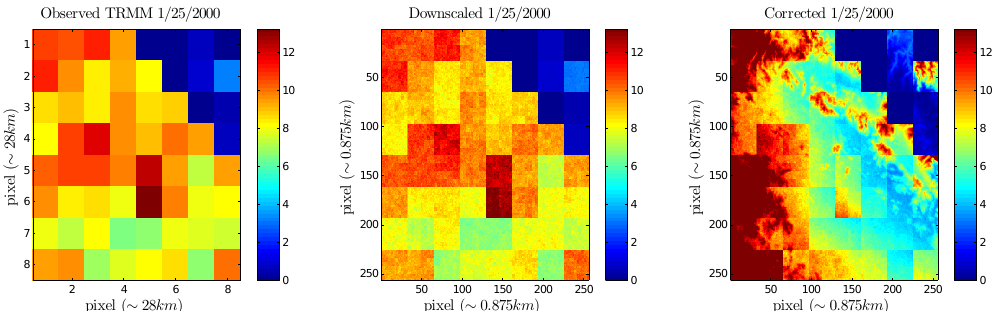
Figure 9. Comparison of observed, downscaled and corrected rainfall measurements for day 25 January 2000 and 1000 realizations ( β = 0.0266 and σ =